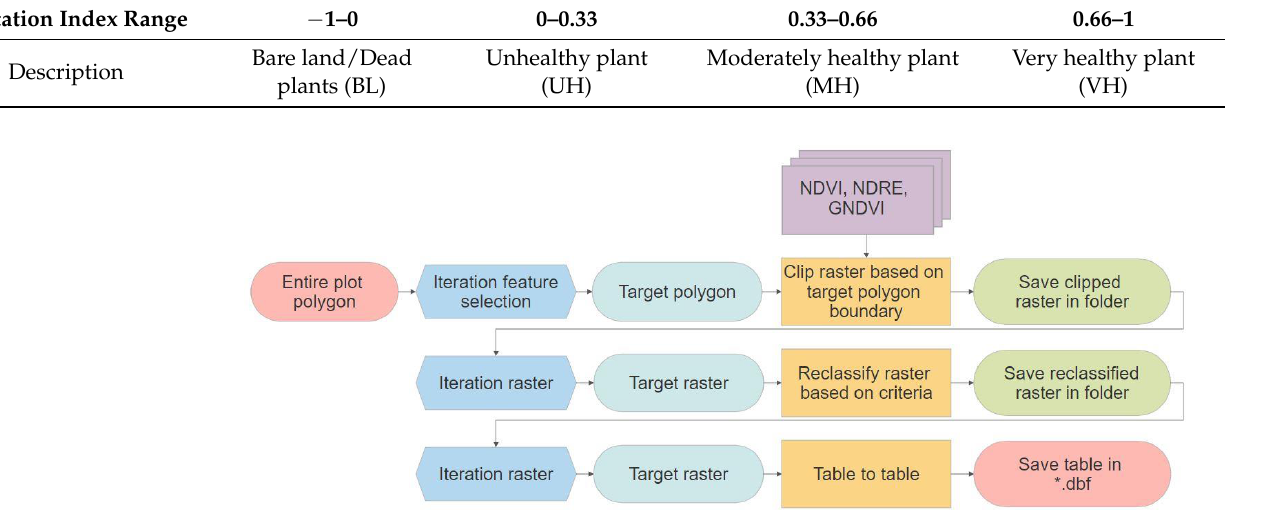
Figure 2. The process of categorizing Miscanthus stands in four categories (bare land or dead plants (BL), less healthy plants (UH), moderately healthy plants (MH), and very healthy plants (VH)) using Model builder in ArcGIS10.7.1. The target polygon means the boundary of shapefile about each quadrat and machinery-harvest area. The target raster indicates individual NDVI, NDRE, and GNDVI map. The *.dbf represents the dBase database